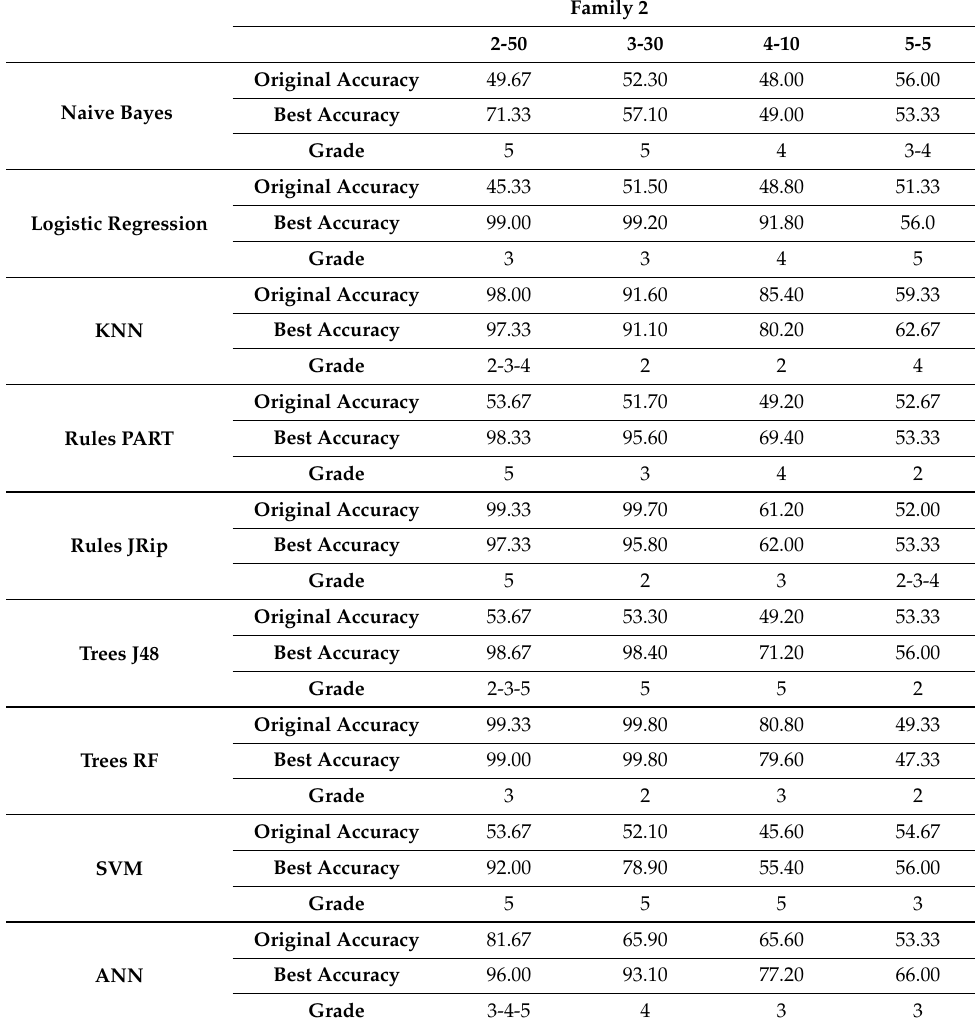
Table A2. Table corresponding to results of artificial data from Family